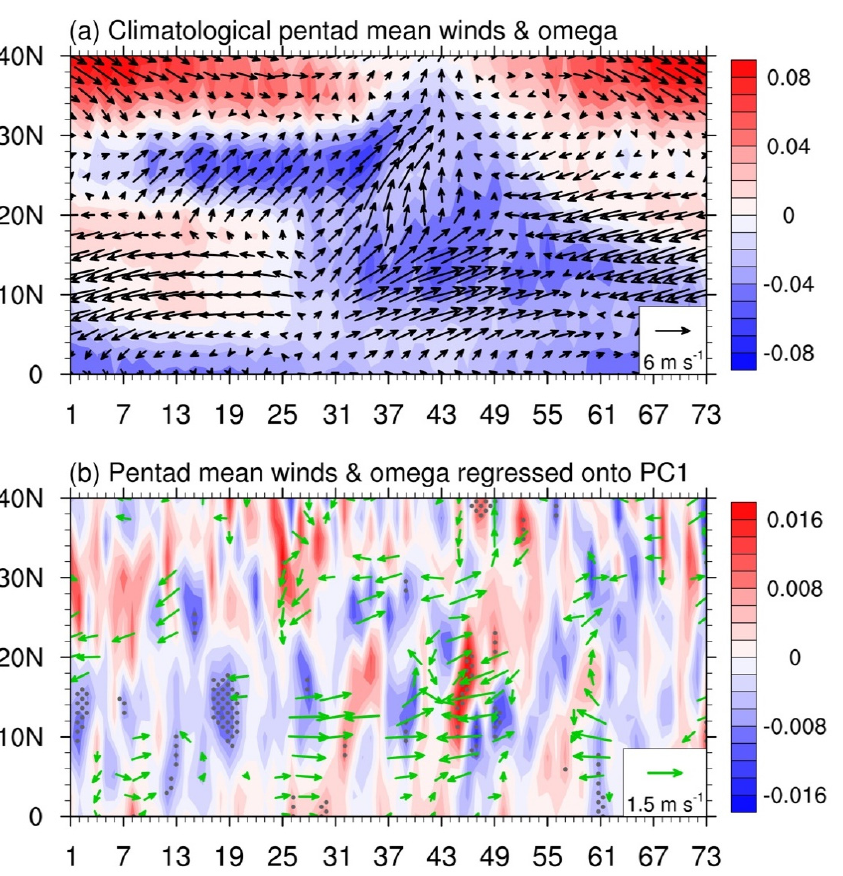
Figure 7. ( a ) Climatological pentad mean horizontal winds (vector, unit: m s − 1 ) and pentad mean 850–500 hPa omega (shading, unit: Pa s − 1 ) for the period of 1979–2018. ( b ) pentad mean horizontal winds and pentad mean 850–500 hPa omega regressed onto the normalized time series of PC1. The data are averaged across the SCS over the longitude between 110° E and 120° E. Dotted areas and green vectors indicate that the regression coefficient of omega and horizontal winds are significant at the 90% confidence level in ( b ).